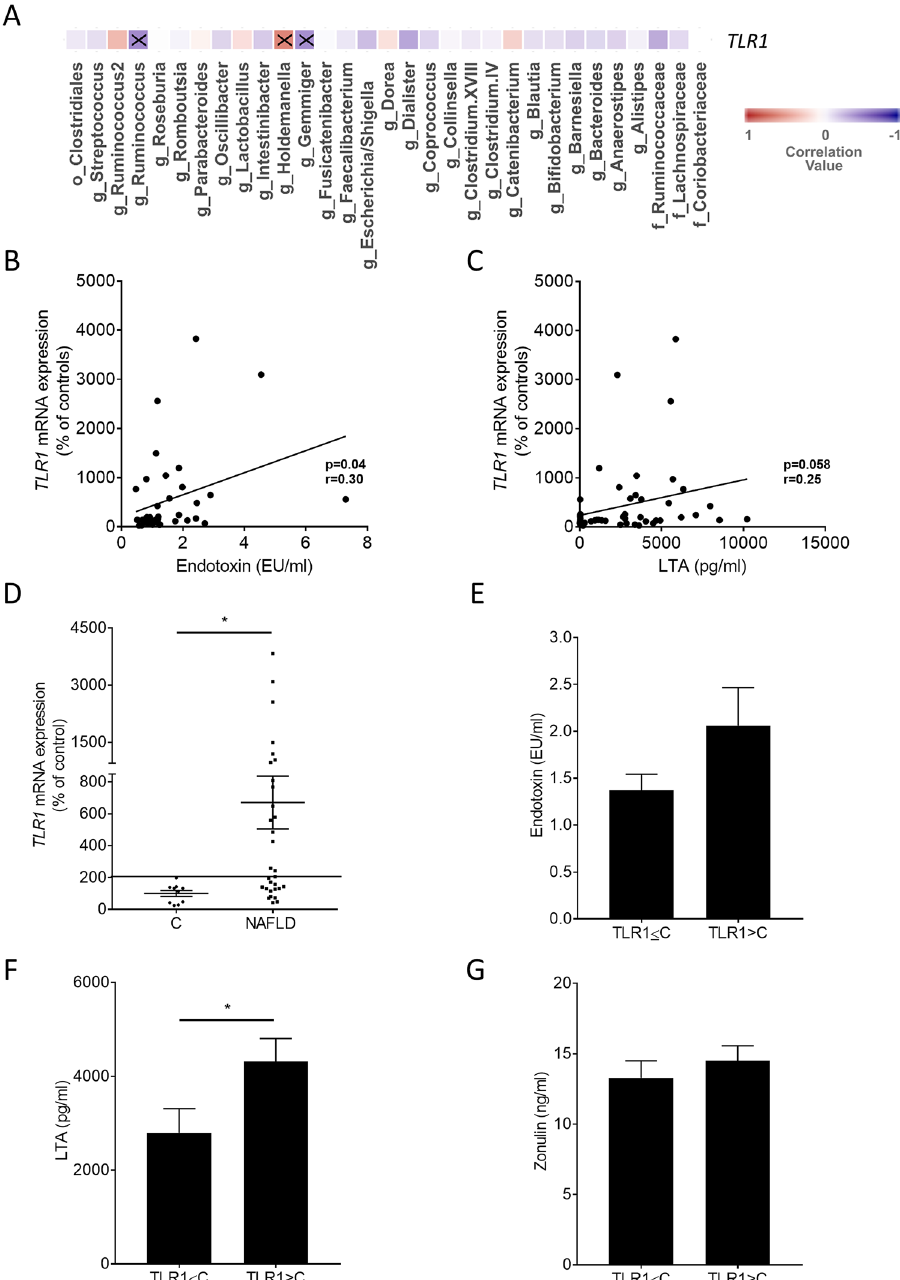
Figure 4. Correlation analyses of TLR1 mRNA expression and bacterial taxa or markers of intestinal permeability as well as markers of intestinal permeability stratified to TLR1 . ( A ) Heatmap showing the Pearson correlation between the bacterial taxa and TLR1 and correlation analysis of TLR1 mRNA expression in human PBMCs with ( B ) endotoxin and ( C ) LTA concentrations in plasma. ( D ) TLR1 mRNA expression, concentration of ( E ) endotoxin, ( F ) LTA and ( G ) zonulin stratified according to TLR1. Letters before the name of bacterial communities represent the taxonomical level, g = genus, f = family, o = order. Higher values in red above 0 show a positive correlation, while values lower than 0 in blue indicate a negative correlation. Correlations marked with an X are statistically significant. Line indicates the cut-off of 200% TLR1 mRNA expression. TLR1 expression ≤ C, patients with NAFLD showing a TLR1 mRNA expression in PBMCs ≤ TLR1 mRNA expression in PBMCs of C; TLR1 expression > C, patients with NAFLD showing a TLR 1 mRNA expression in PBMCs > TLR1 mRNA expression in PBMCs of C. Data are shown as means ± SEM, n = 7–14 controls, n = 16–31 NAFLD patients, * p ≤ 0.05. C healthy controls, LTA lipoteichoic acid, NAFLD patients with non-alcoholic fatty liver disease, PBMCs peripheral blood mononuclear cells, TLR toll-like